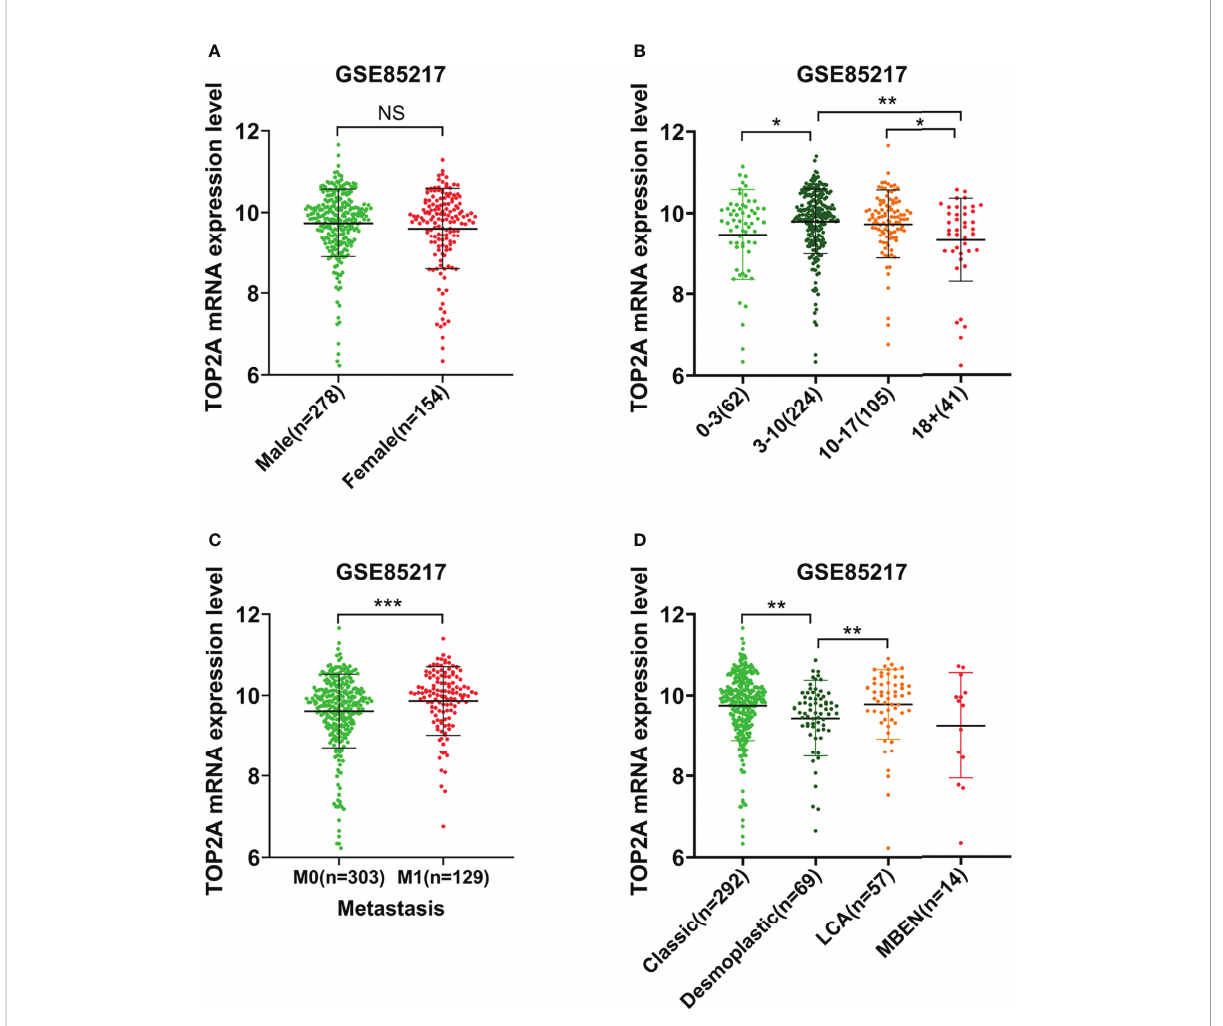
FIGURE 2 The relationship between the expression level of TOP2A and clinicopathological features in GSE85217 dataset. (A) The expression level of TOP2A in different genders. (B) The expression level of TOP2A in different age groups. (C) The expression level of TOP2A in different metastatic status. (D) The expression level of TOP2A in different histology